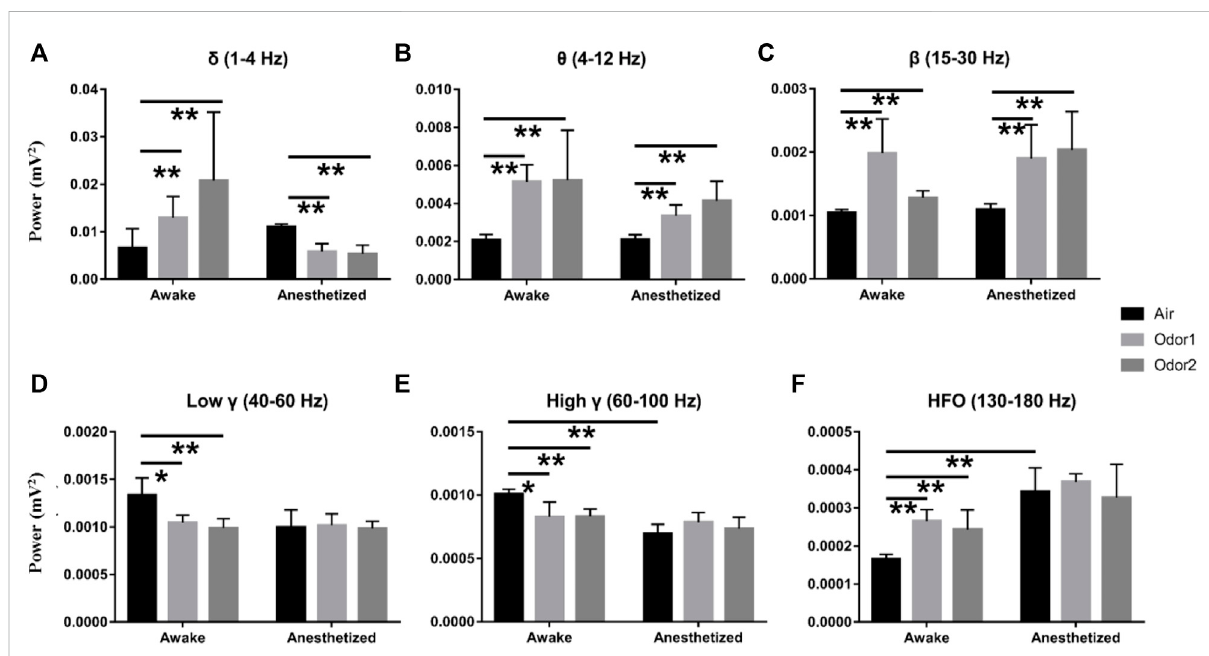
FIGURE 4 Histogram displaying the quanti fi cation of power spectrum in the δ - (A) , θ - (B) , β - (C) , low γ - (D) , high γ - (E) , and HFO-bands (F) in 3 awake and 3 anesthetized rats under the stimulation of air, nonanoic acid (NA, odor 1), and amyl hexanoate (AH, odor 2) with 2 trials per odor per rat. ** p < 0.01, * p < 0.05,and ANOVA followed by Fisher ’ s least signi fi cant difference (LSD).